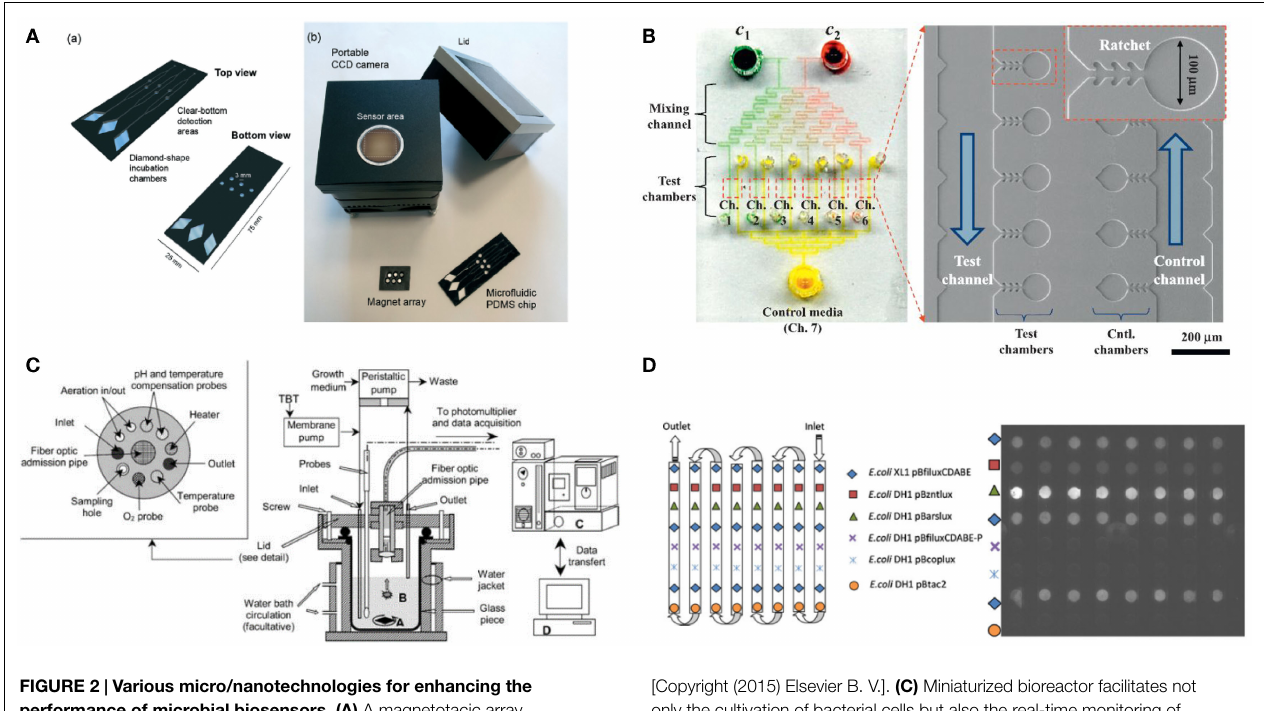
FIGURE 2 | Various micro/nanotechnologies for enhancing the performance of microbial biosensors . (A) A magnetotacic array device was introduced that can improve the positioning of microbial biosensor by separating a detection area from a cultivation area. The figure is reprinted with the permission from Roda et al. (2013) [Copyright (2013) Royal Society of Chemistry]. (B) A microfluidic device was developed for multiplex detection of small volume samples (Kim et al., 2014). The image is reproduced with the permission from Kim et